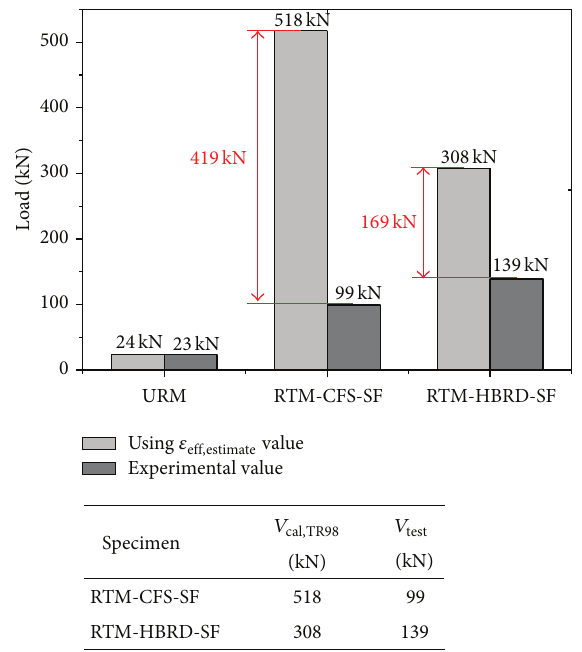
Figure 11: Evaluation of shear strength.